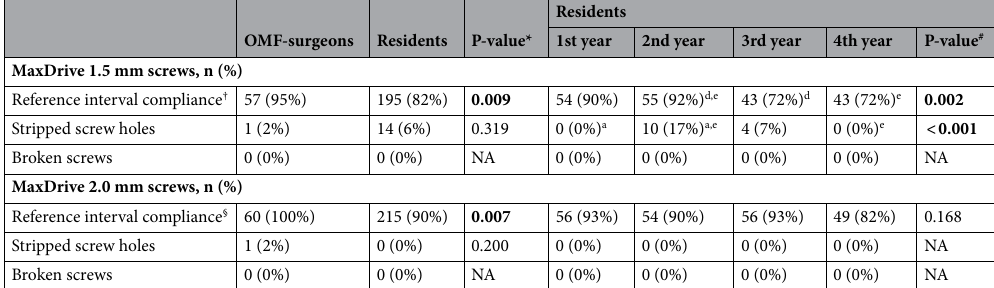
Table 4. The compliance with the reference intervals and the number of complications during osteosynthesis screw insertion. The bold P-values represent statistically significant differences. Each superscript denotes significant differences in the pairwise comparisons (see P-values below): ‘a’ is derived from the pairwise comparison between first- and second-year residents, ‘b’ between first- and third-year residents, ‘c’ between first- and fourth-year residents, ‘d’ between second- and third-year residents, ‘e’ between second- and fourth- year residents, and ‘f’ between third- and fourth-year residents. 1.5 mm screw reference interval compliance: a P > 0.999; b P = 0.064; c P = 0.064; d P = 0.028 ; e P = 0.028 ; f P > 0.999; stripped screw holes, a P = 0.008; b P = 0.712; c P = NA; d P = 0.920; e P = 0.008; f P = 0.712; broken screws: NA. 2.0 mm screw reference interval compliance: non-significant differences between subgroups and, thus, no pairwise comparisons were performed; stripped screw holes: NA; broken screws: NA. *Comparison between OMF-surgeons and residents. # Comparison between the residency years. † Reference interval 1.5 mm screws: 73.7–127.9 Nmm. § Reference interval 2.0 mm screws: 233.9–629.5 Nmm. OMF-surgeons oral and maxillofacial surgeons, NA not